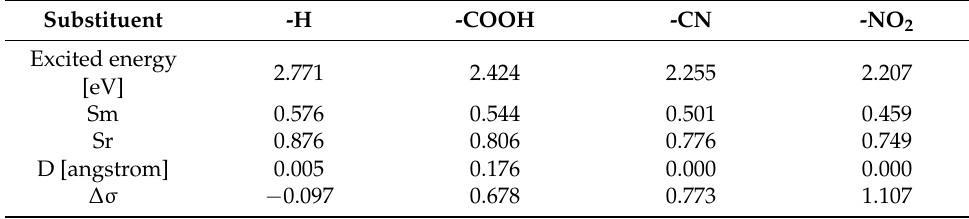
Table 1. Transition indices of molecular systems with different substituents in S 1